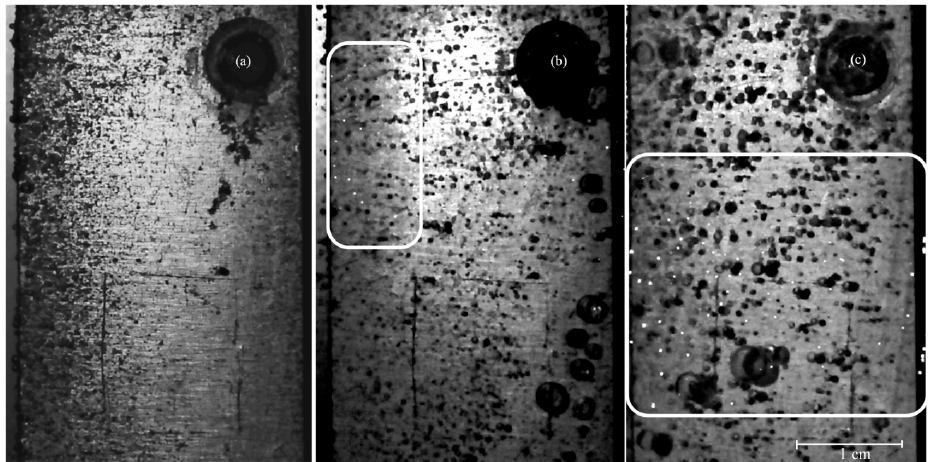
Figure 2. Different stages of the oxide layer formation: ( a ) anodizing process; ( b ) microarc appearance (presented in a white frame); ( c ) plasma electrolytic oxidation (PEO) treatment and increasing of microarc number discharges (presented in a white frame).